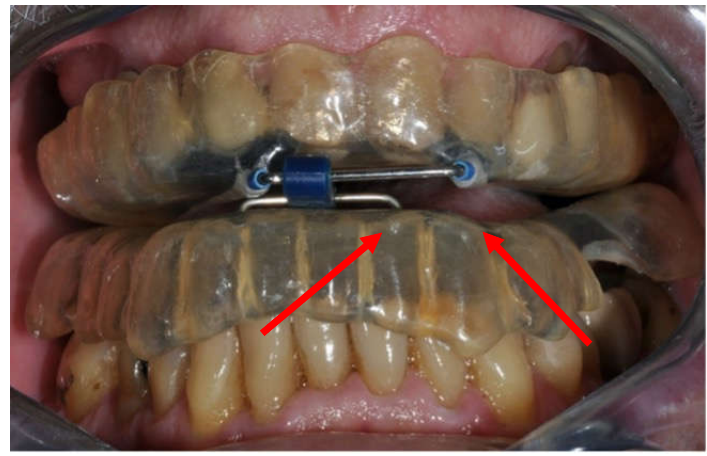
Figure 1. The mandibular advancement device (MAD) was worn by the patient. The appliance was realized with an anterior displacement of 4.7 mm. The anterior articulation system allowed the patient to open and move the teeth laterally, reducing discomfort. No short- or long-term side effects were noted at follow-up, and compliance remained high. After two years, the PSG showed a significant decrease in all measurements. Thus, AHI reached a value of 14.7/h in the lateral position and of 21.4/h in the supine position, indicating a decrease of 58.9% in the lateral position and of 75.5% in the supine position. ODI decreased from 20.4/h before treatment to 12.1/h post-treatment. The patient also changed his usual sleeping positions: time in the supine position increased to 59.6%, while time in the lateral position decreased to 40.4%. The initial indicated a decrease in severity from severe to mild. Overall, the patient reported a significant improvement in his quality of life.